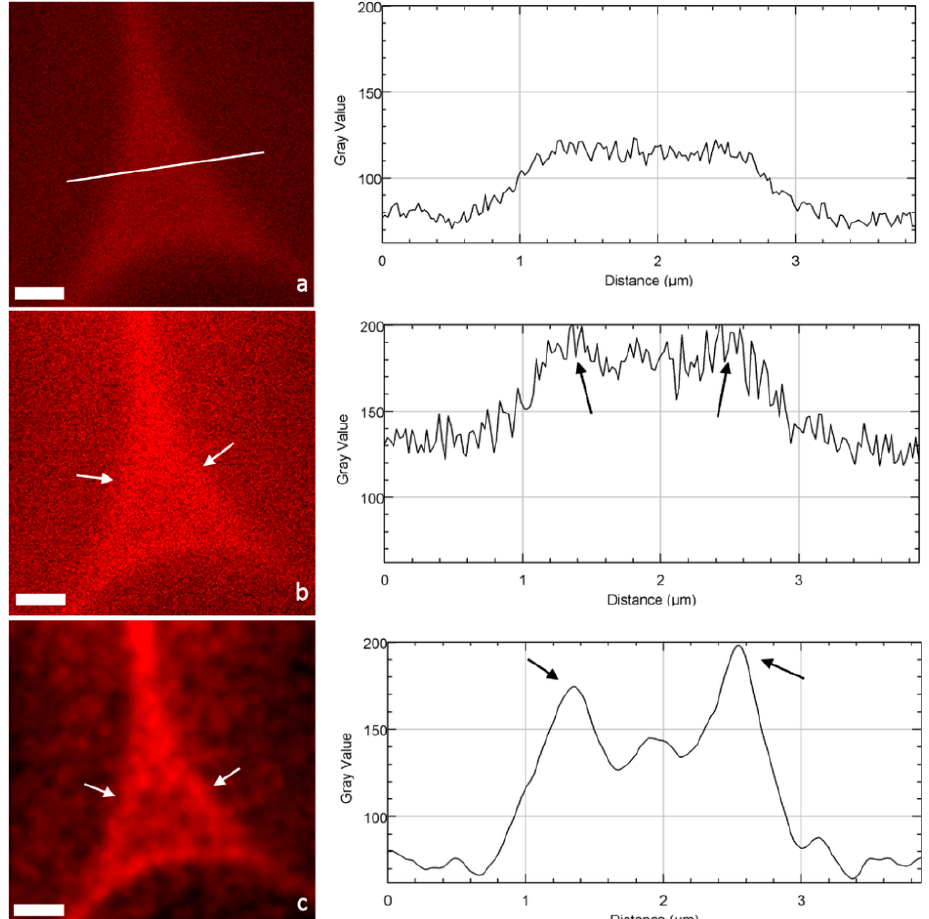
Figure 4. Images of cell corners and the corresponding intensity profile (line) acquired in the same area by ( a ) CLSM, ( b ) STED, and ( c ) STED + deconvolution (scale bar: 1 µm). Fine structures corresponding to the ML are not visible in the CLSM image, but become detected in the STED mode (arrows) and more precisely in the STED with deconvolution mode (arrows), with a large increase in amplitude and an improvement in the signal-to-noise ratio.